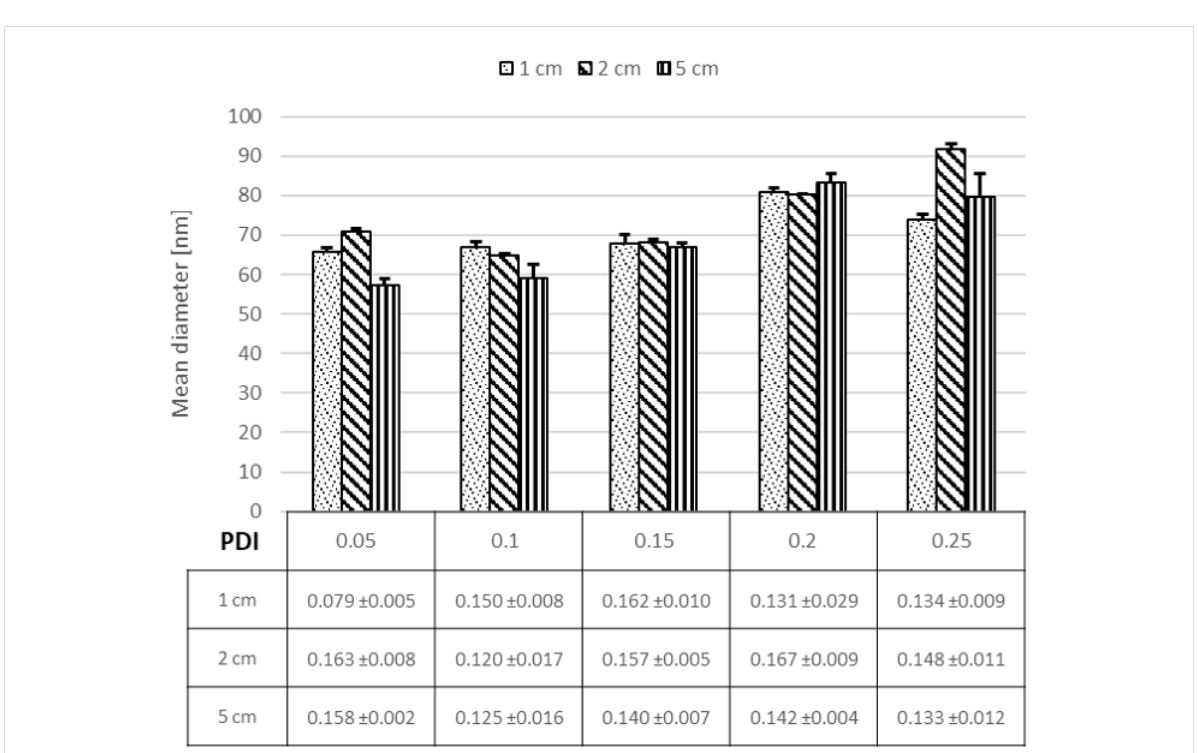
Figure 6: Effect of solvent nature (acetonitrile (ACN), dimethyl sulfoxide (DMSO) and acetone) on NP size and PDI at different flow rate ratios.